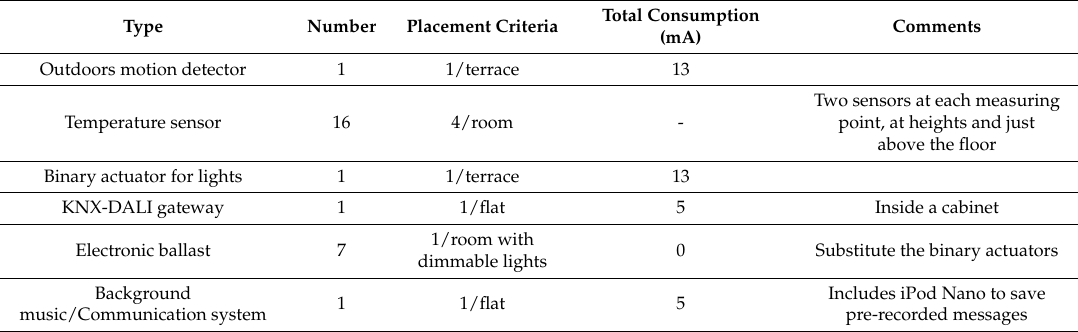
Table 6. Installed sensors and actuators in advanced home automation system.